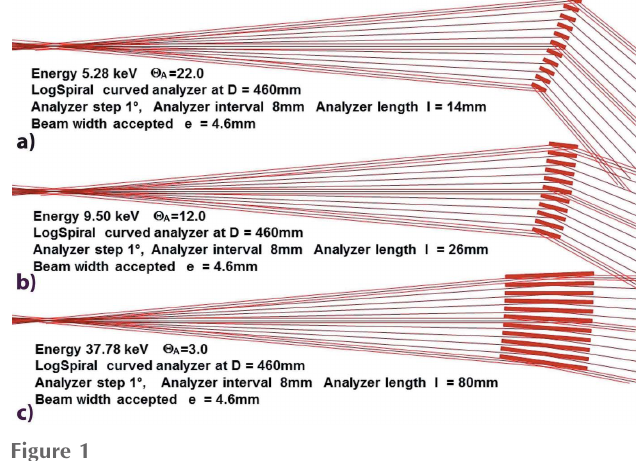
Figure 1 The geometric parameters of the LogSpiral curved MAD system are determined by the energy range used; the corresponding values of angles (cid:2) A and 2 (cid:2) A for a Si(111) analyser and the detector determine the length and separation of the analyser crystals. ( a ) Using (cid:4) 5 keV X-rays, the gap between analyser crystals must be large enough (interval 8 mm, thickness 3 mm ! gap 5 mm) and their length small enough to allow the passage of adjacent beams; at low energy, filtered beams are more easily partially cut by adjacent analyser crystals. ( b ) Using 9.5 keV X-rays, a crystal length of 26 mm allows filtering of 4.6 mm-wide beams. ( c ) Using (cid:4) 40 keV X-rays, a crystal length of 26 mm allows filtering of 1.6 mm-wide beams; the length of the analyser crystals should be longer ( e.g. 80 mm) to allow filtering of a reasonable beam width ( e.g. 4.6